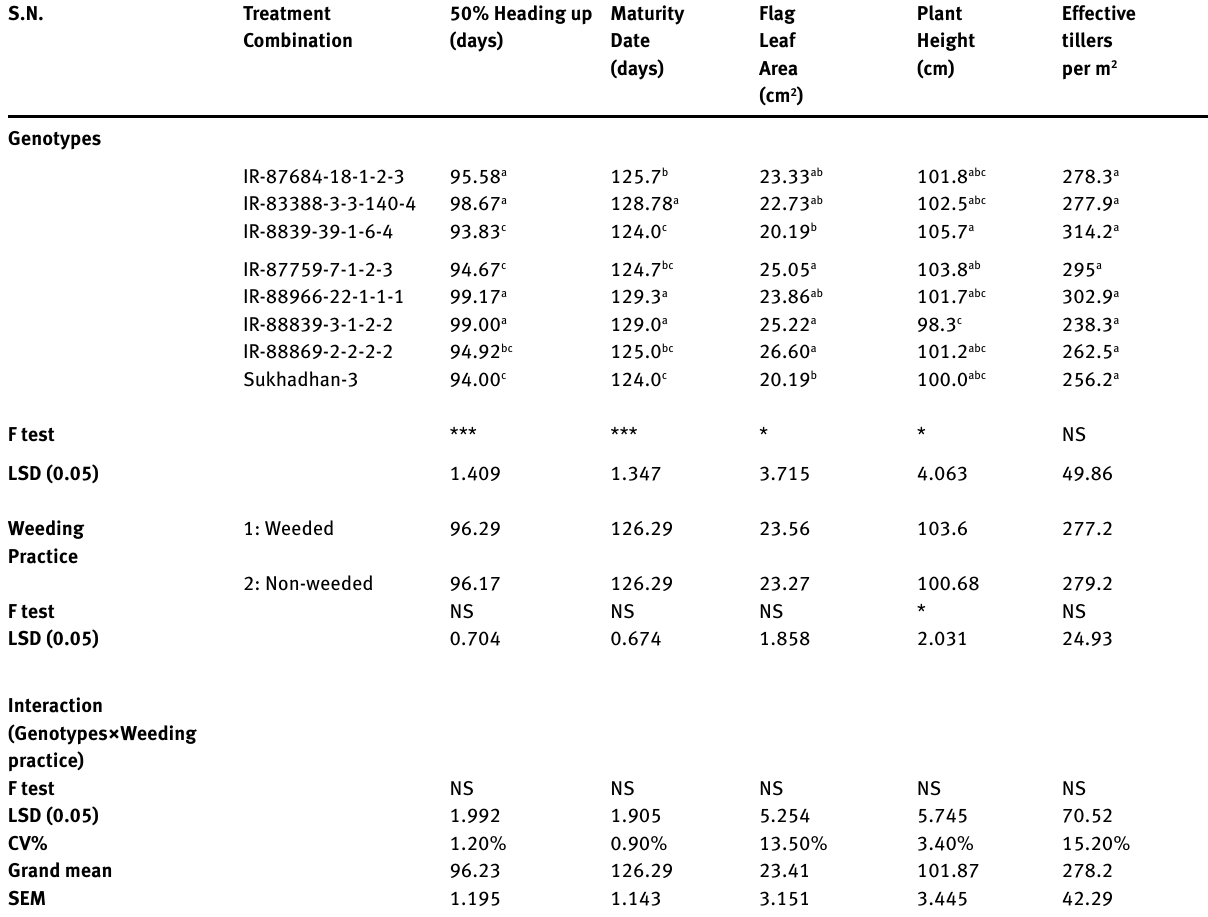
Table 1: Effect of genotypes, weed management practices and their interaction on growth traits of rice genotypes at Lamjung, Nepal, 2016